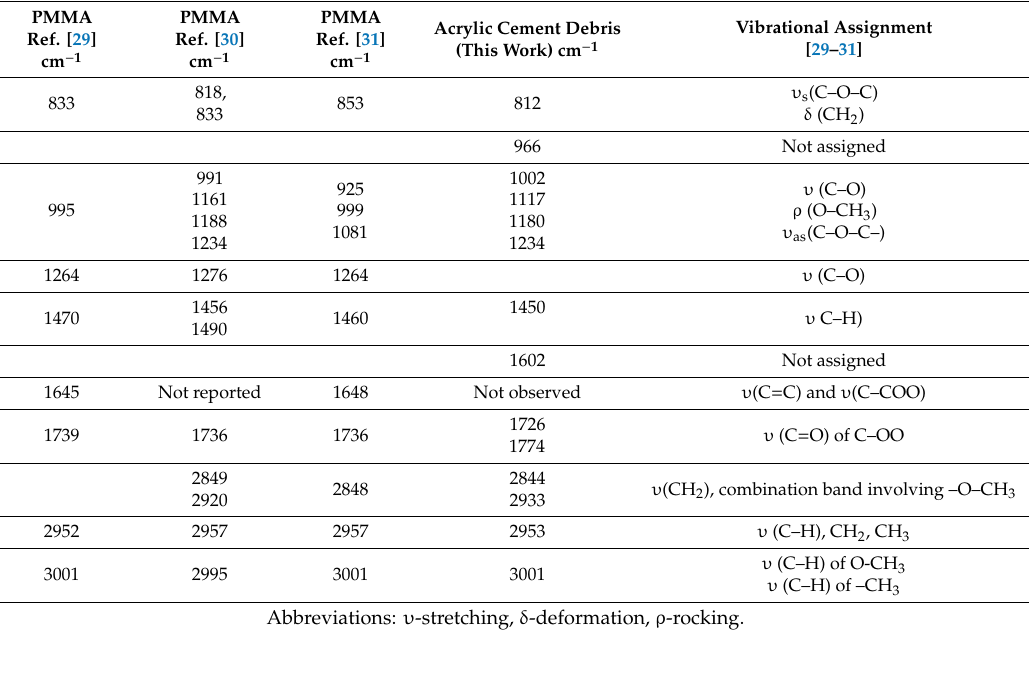
Table 2. Observed Raman bands / cm − 1 in aged acrylic cement from prosthetic retrieval compared to literature data of pristine polymethyl methacrylate (PMMA) and their assignment.